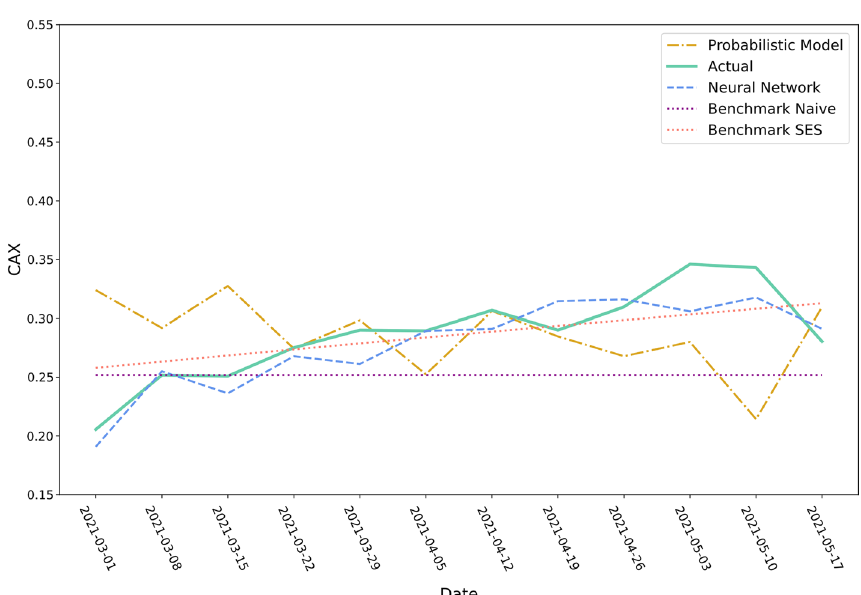
Fig. 9 Predicted container availability for the port of Qingdao (forecasting origin: 01.03.2021). Source :